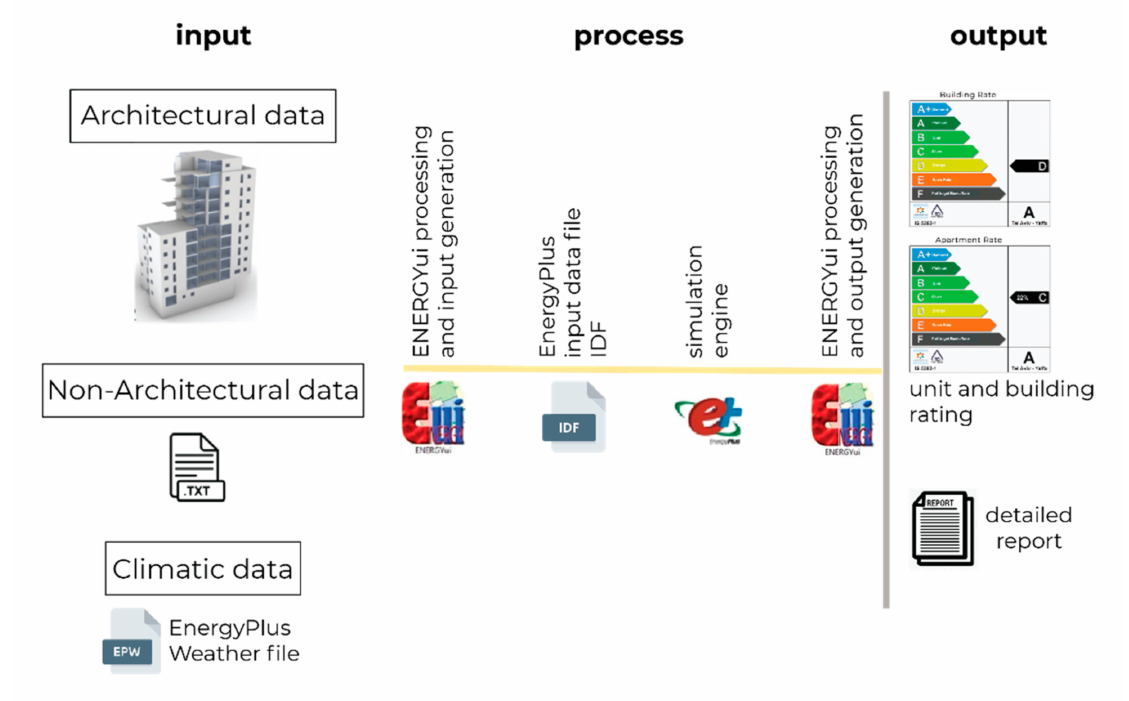
Figure 1. ENERGYui